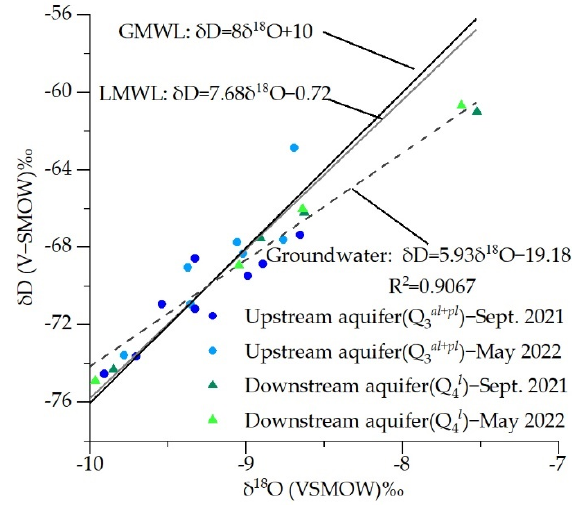
Figure 8. Relationship between δ D and δ 18 O of groundwater in the study area. Sampling sites: Upstream aquifer (Q 3 al+pl ) and downstream aquifer (Q 4 l ); sampling times: September 2021 and May 2022.